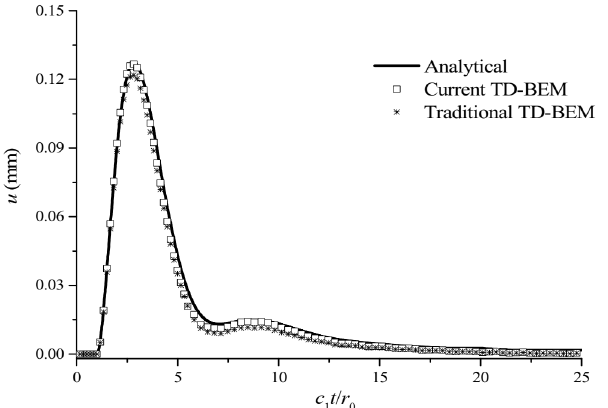
Figure 13. Calculated radial displacements at r = 2 m from the proposed 3D TD-BEM, the traditional 3D TD-BEM and the analytical solution.